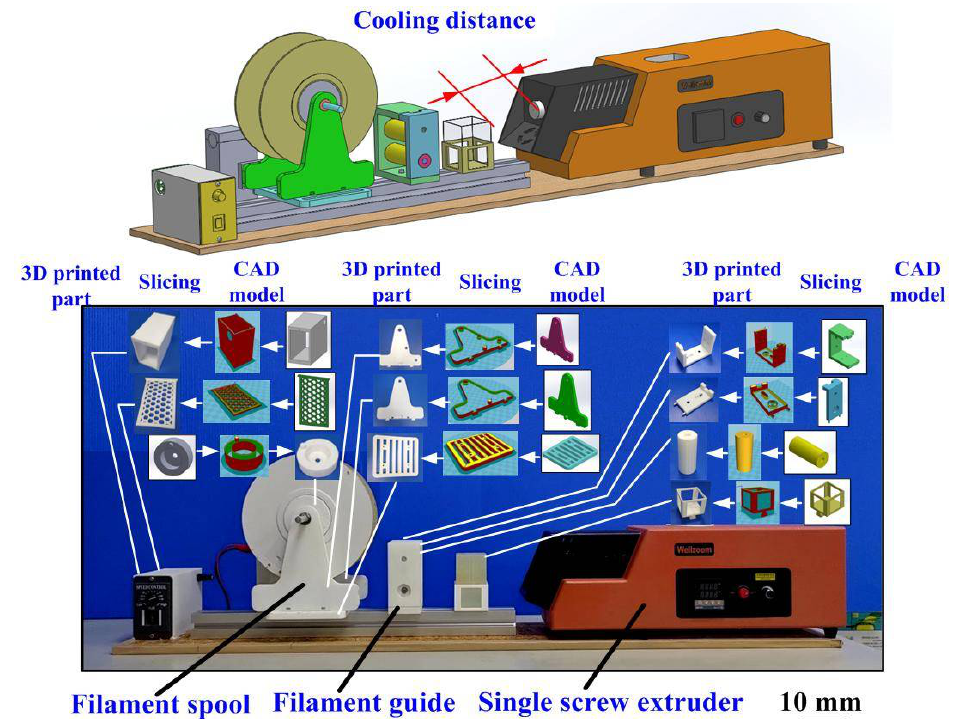
Figure 2. Homemade PLA filament making system.